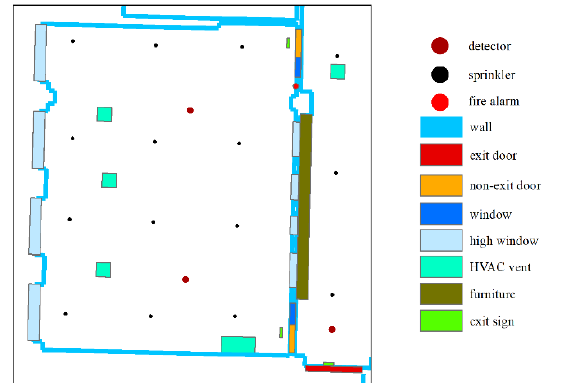
Figure 4 : 3D polygons representing features-of-interest.